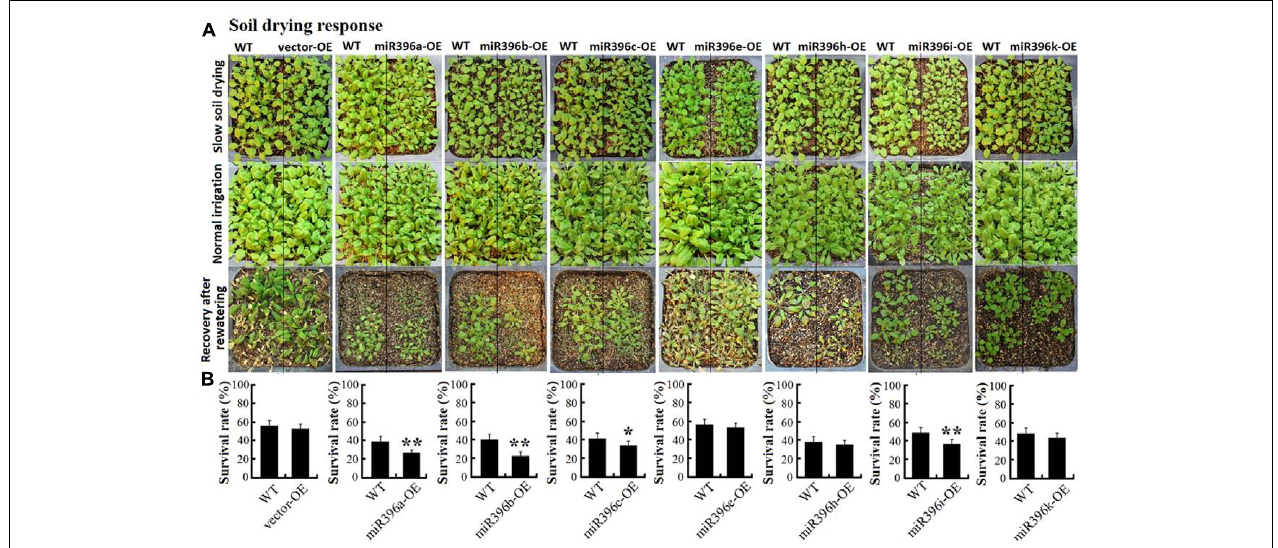
FIGURE 7 | Soil drying response of miR396a/b/c/e/h/i/k-OE transgenic Arabidopsis seedlings. (A) Photographs of WT, vector-OE, and miR396a/b/c/e/h/i/k-OE Arabidopsis for the state of slow soil drying, normal irrigation, and recovery after rewatering. (B) Seedling survival rate analysis when Arabidopsis were recovery after rewatering. Data are average of five replicates ± SD, asterisks indicate significant difference applying Student’s t -test ( ∗ P < 0.05; ∗∗ P < 0.01; ∗∗∗ P <